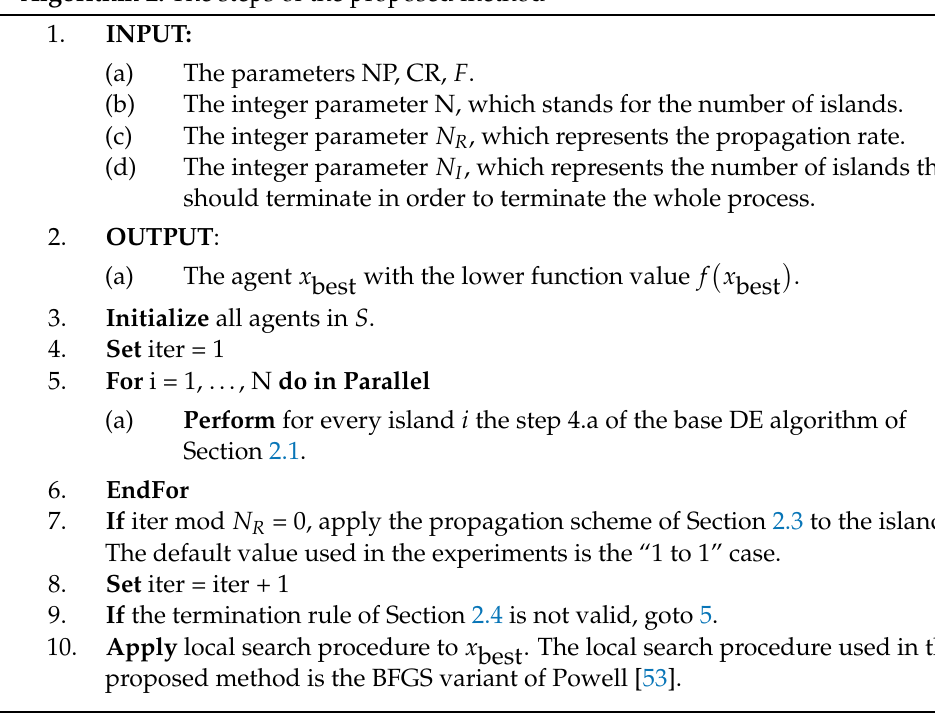
Algorithm 2: The steps of the proposed